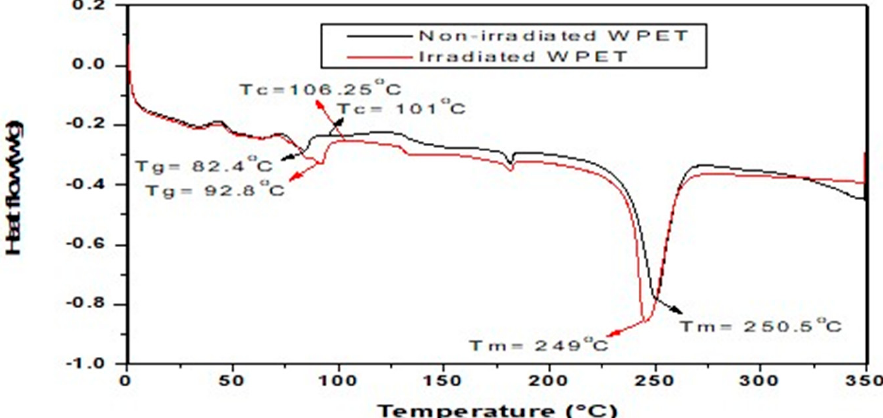
Figure 2. Differential scanning calorimetry (DSC) thermogram curve for waste polyethylene terephthalate (WPET) before and after gamma irradiation.